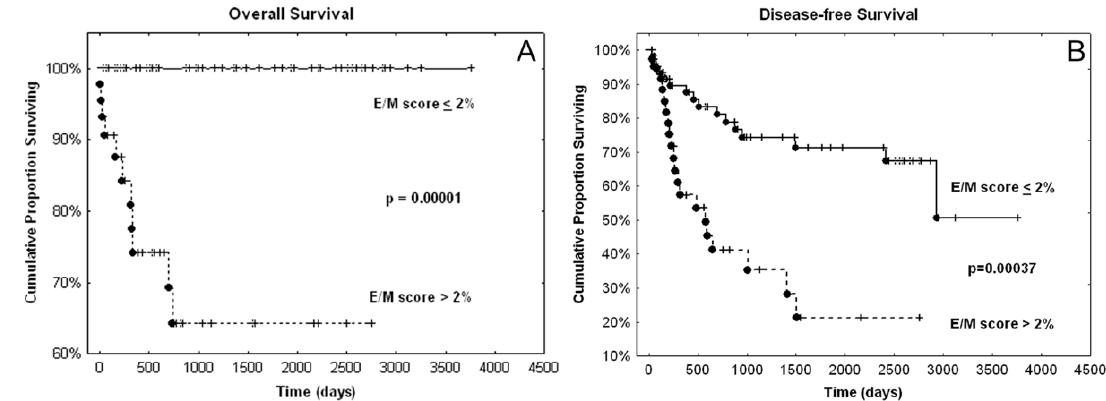
Figure 6. Overall survival (OS) ( A ) and disease-free survival (DFS) ( B ) curves resulting from the binarized E / M score. The dots indicate cases of death ( A ) or recurrence ( B ), while the crosses indicate live ( A ) or disease-free ( B ) patients. p -values resulted from log-rank test.